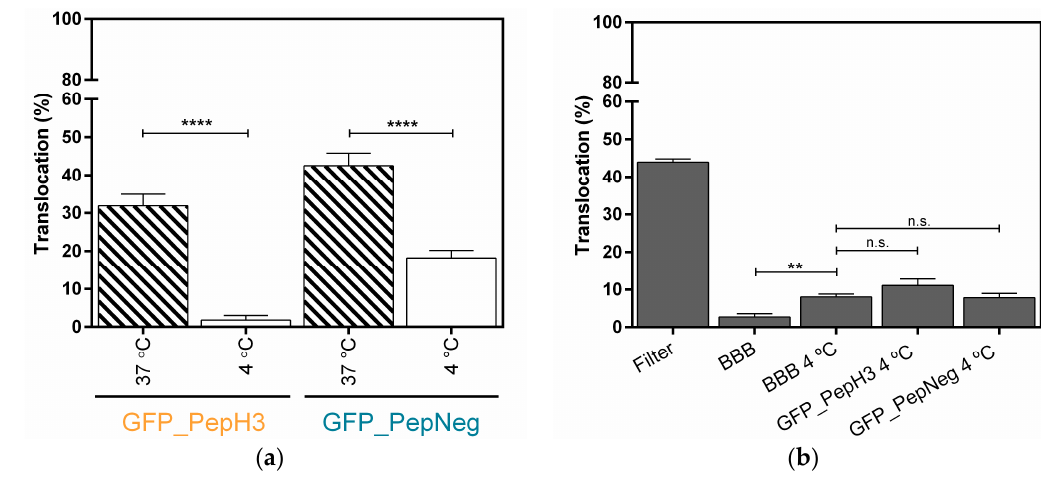
Figure 2. Metabolic inhibition studies of GFP_PepH3 and GFP_PepNeg cellular-translocation pathways and the model-integrity study. ( a ) Percentage of translocation for GFP_PepH3 (orange) and GFP_PepNeg (blue), determined by GFP fluorescence intensity detection, at 37 °C (dashed) and at 4 °C (white). A one-way ANOVA statistical test followed by a Dunnett’s test was used to compare each fluorescence measurement at 4 °C with the respective experiments at 37 °C (**** p < 0.0001); ( b ) Percentage of FD40 translocation determined by fluorescence intensity detection. The recorded percentages were compared to three controls: one with the transwell without cells (“Filter”) and the others consisting of the BBB model with no peptide incubation at 37 °C (“BBB”) and at 4 °C (“BBB 4 °C”). The statistical test used to compare the fluorescence measurements obtained was a one-way ANOVA followed by a Dunnett’s test (** p ≤ 0.01; n.s., not significant). The values were obtained from duplicates of three independent experiments.